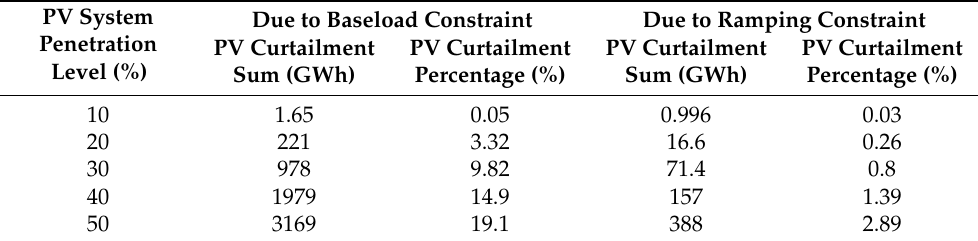
Table 5. PV system’s performance in terms of curtailing the PV system due to the grid’s constraints at various PV penetration levels to the grid in Riyadh, 2017.